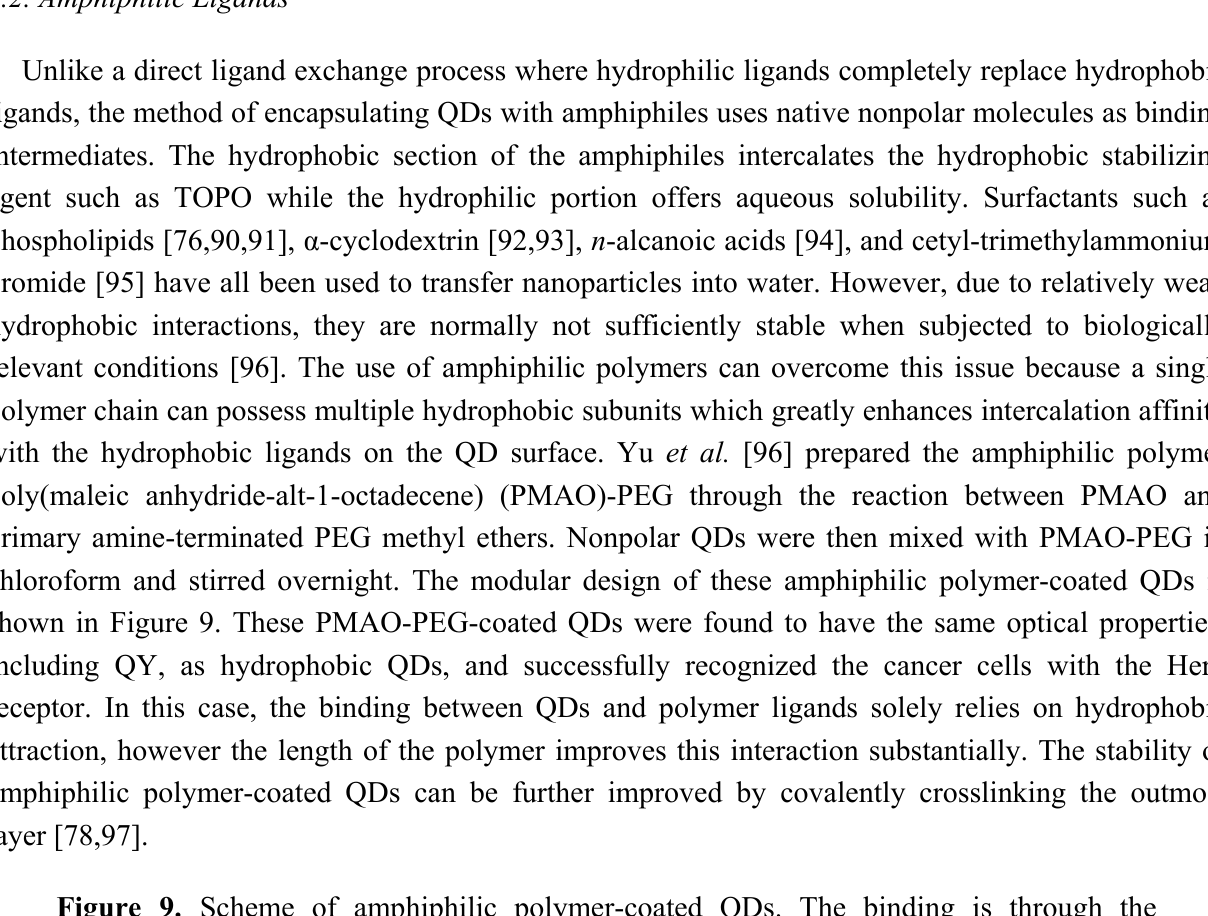
Figure 9. Scheme of amphiphilic polymer-coated QDs. The binding is through the hydrophobic attraction between the ligands that initially cap QDs and hydrophobic portion of the amphiphilic polymer. The outmost layer is modified with functional group for linking with other molecules [96]. Copyright 2007 American Chemical